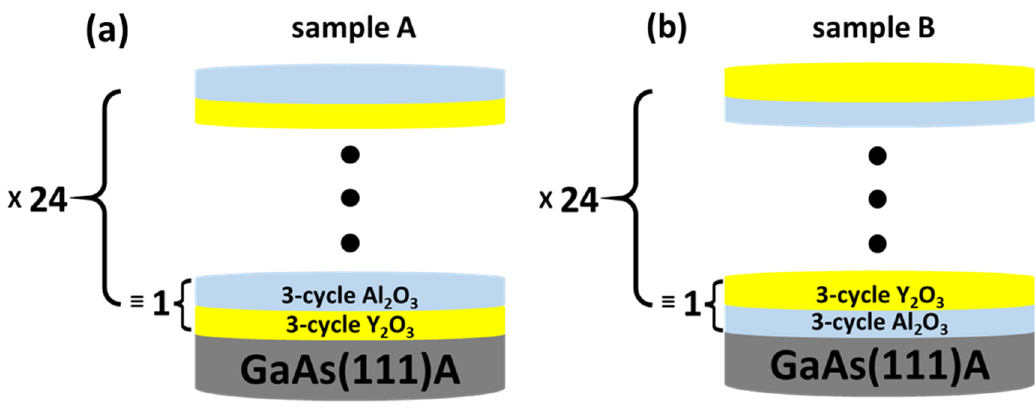
Figure 1. Schematics of snl multilayers of 24 periods of ( a ) atomic layer deposition (ALD)-Al 2 O 3 / -Y 2 O 3 (sample A) and ( b ) ALD-Y 2 O 3 / -Al 2 O 3 (sample B), with each constituent consisting of 3 ALD cycles.